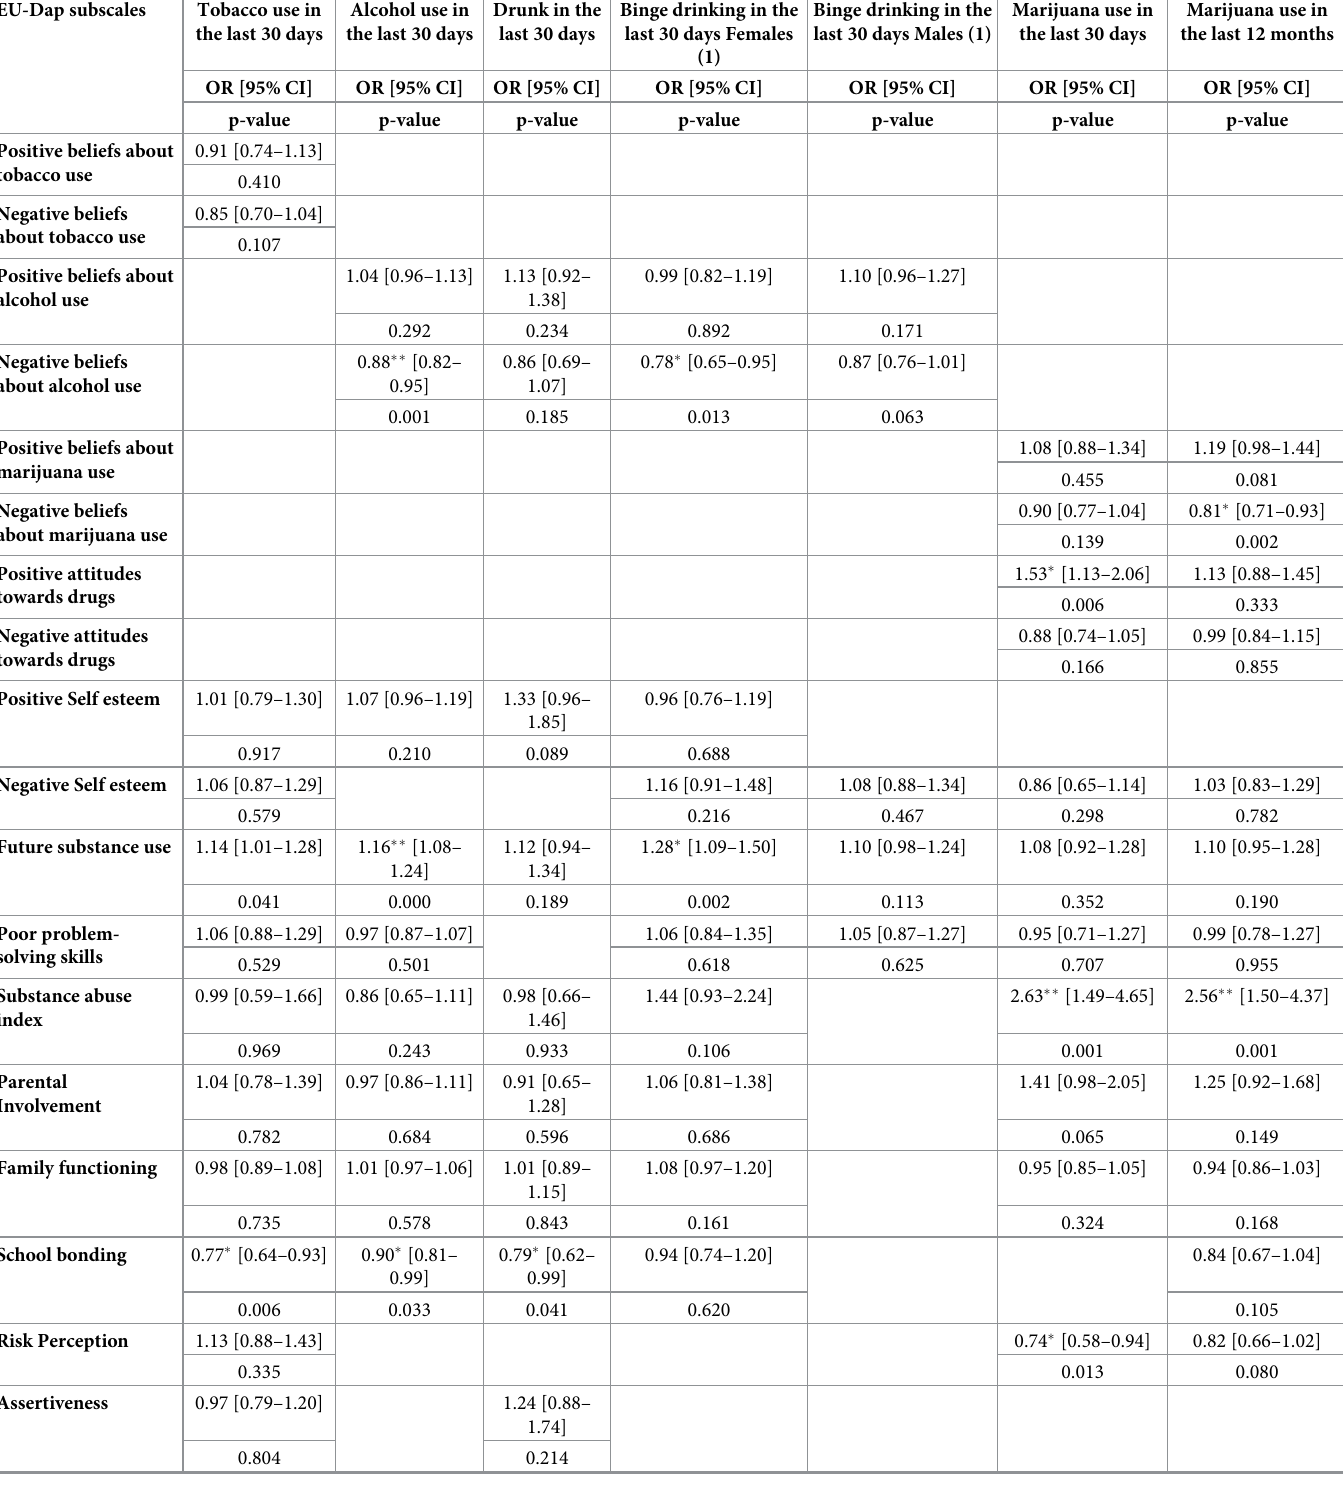
Table 5. Multivariable associations of EU-Dap subscales and substance use. EU-Dap